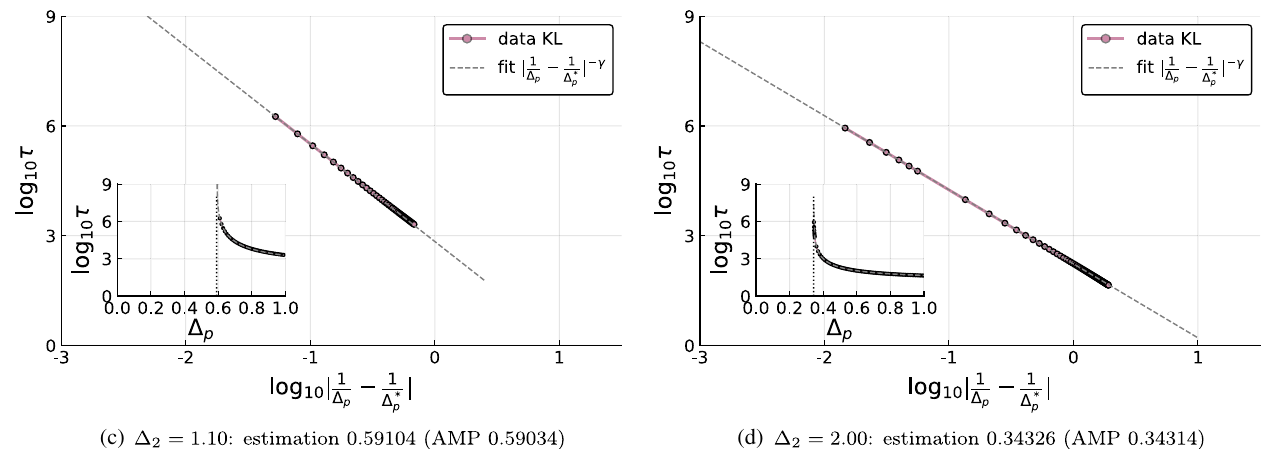
¯ C 0 ¼ 1 . The four cases refer to the 2 þ 3